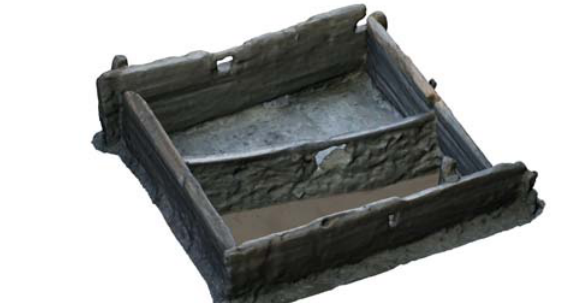
Figure 4. The photo-realistic three-dimensional digital model of the sluice box